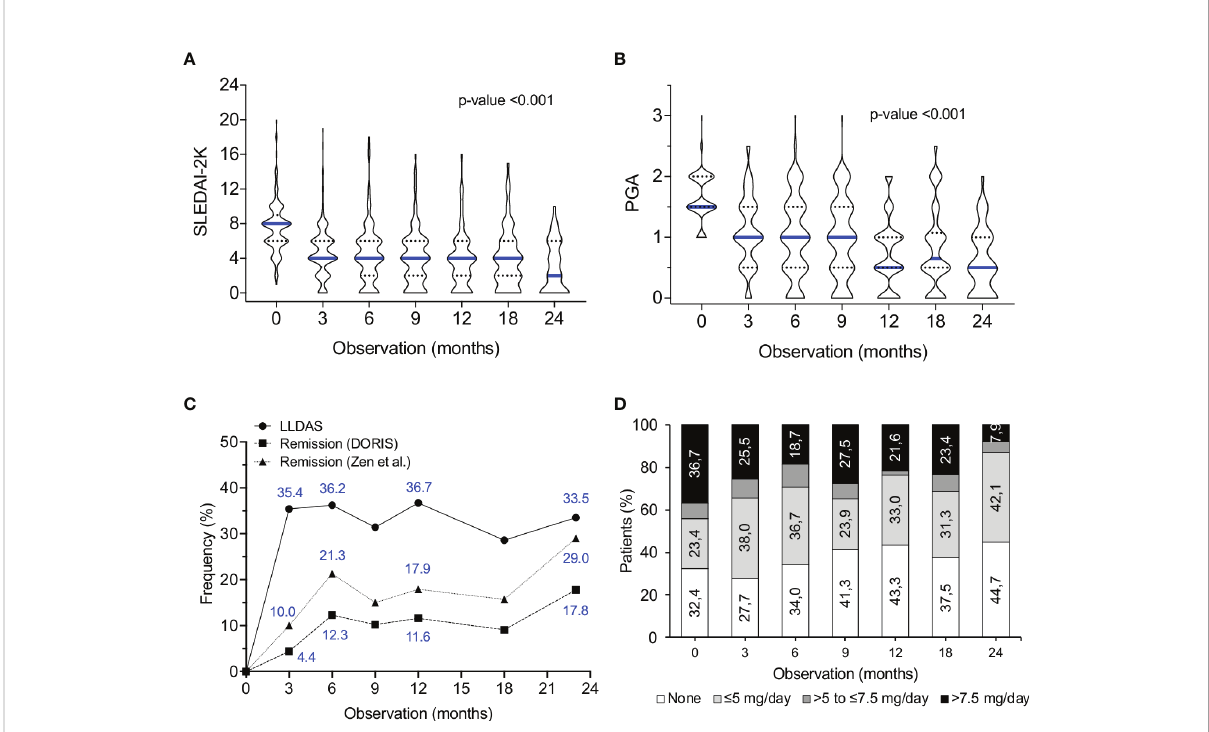
FIGURE 1 Effect of belimumab treatment on SLE disease activity, attainment of therapeutic goals and dose of glucocorticoids. (A, B) Violin plots of SLEDAI-2K (A) and PGA (B) values at consecutive time-points during belimumab treatment. Blue lines represent median values. The non- parametric Skillings-Mack test was used to determine the statistical signi fi cance of longitudinal trends. The number of analysed patients were 178, 164, 136, 109, 74 and 48 at the 3, 6, 9, 12, 18 and 24-month time points, respectively. The number of patients with shorter follow-up were 0, 6, 16, 21, 40 and 53, respectively. (C) Rates (Lundex-corrected) of attainment of low disease activity (LLDAS (30)), remission (according to the DORIS (31) and the Zen et al. (32, 33) de fi nitions) in belimumab-treated patients. (D) Stacked bars demonstrating the glucocorticoid dosage level (none, >0 and ≤ 5 mg/day, >5 to ≤ 7.5 mg/day, >7.5 mg/day prednisone equivalent) in patients under treatment with